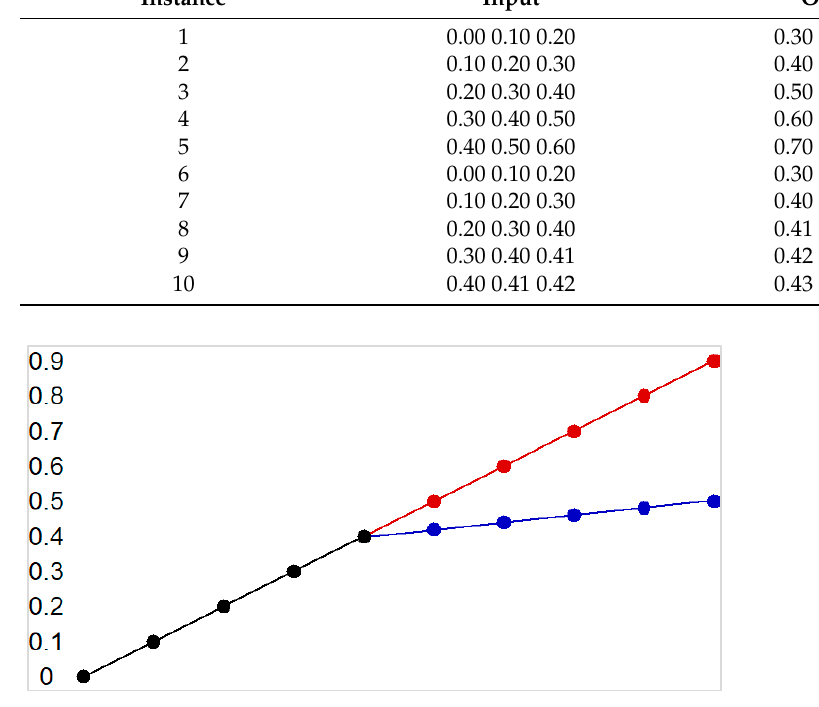
Figure 9. Simple bimodal trajectories.